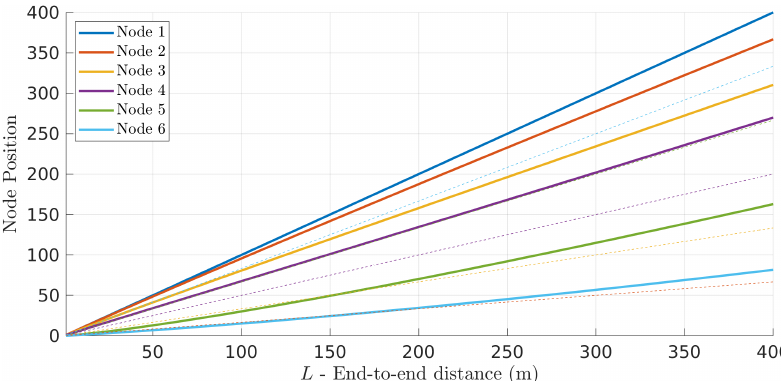
Figure 7. The optimal relay positions (solid lines) are different than the corresponding equidistant positions (dashed lines). Their absolute differences increase (nonlinearly) with network length L .